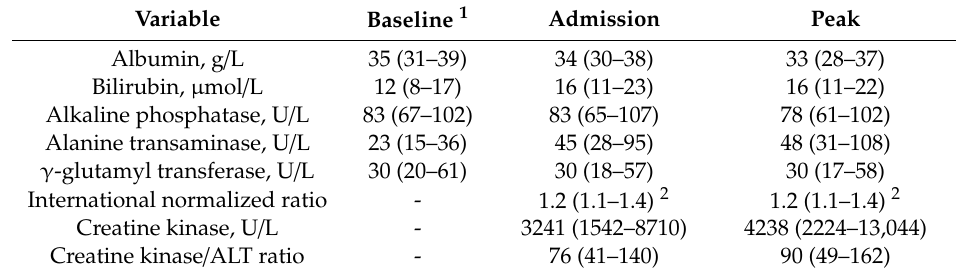
Table 2. Serum biochemistry at peak creatine kinase (CK) level showing median and interquartile